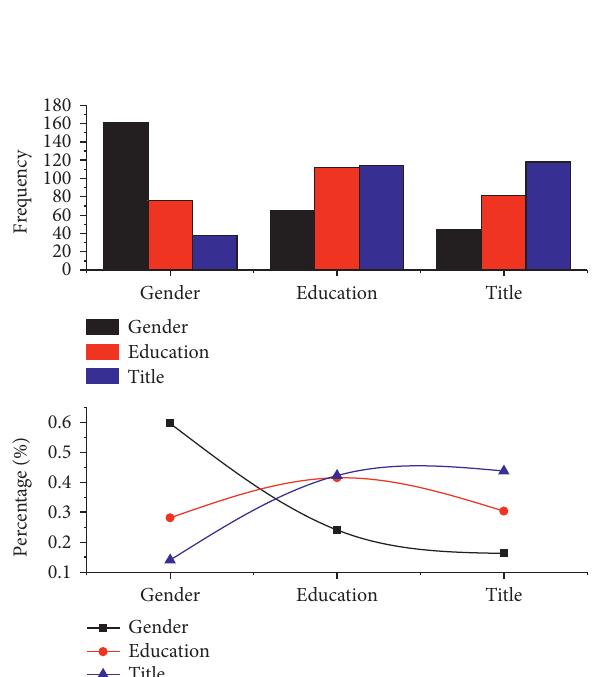
Figure 4: Basic information statistics of the questionnaire